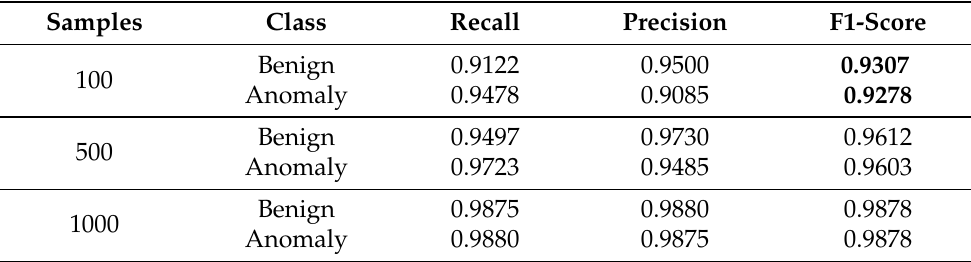
Table 4. Few-shot scenario. Model trained on the SIMARGL dataset (with N additional samples from IoT-23), and tested on IoT-23.